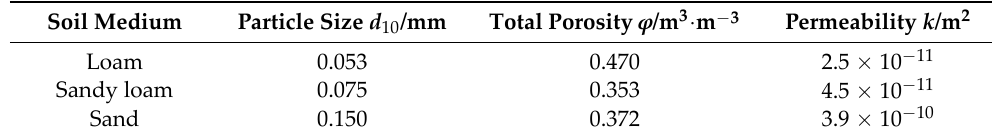
Figure 1. Three different soil porous media that are uniformly placed in a circular bowl. The soil samples were exposed to an air‑dried environment and used to measure total soil porosity. Table 1. Physical properties of three soil medium used in the